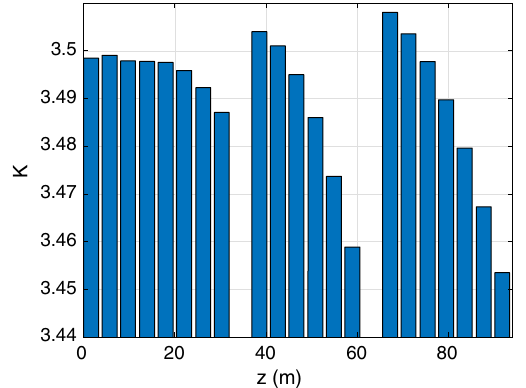
FIG. 6. The undulator strength parameter K used in the fresh- slice multistage XFEL amplification experiment [11]. By gradu- ally moving the on-axis slice to the head, the slice energy becomes higher, since the wake-induced energy loss becomes smaller from the bunch tail to the head. In order to meet the FEL resonance condition, the starting point of the undulator parameter becomes higher from the first to the third stage.